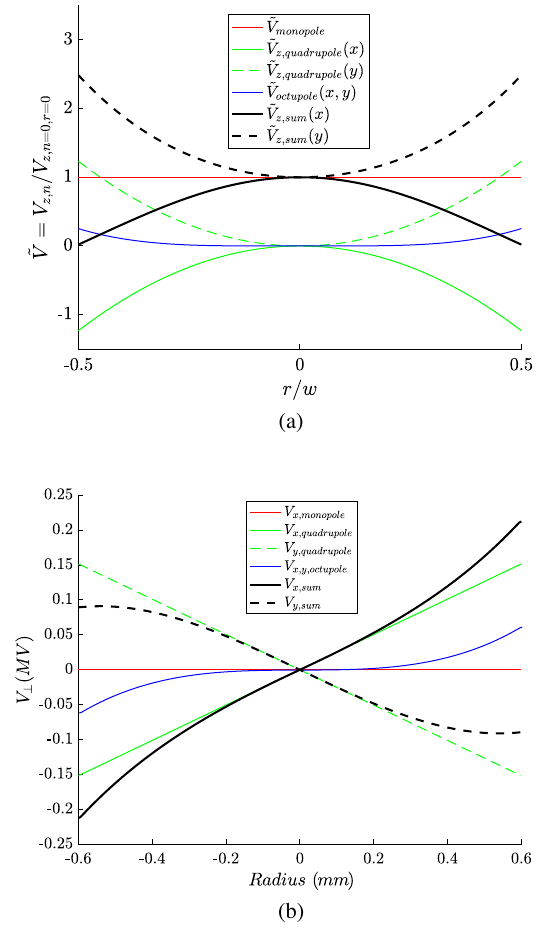
FIG. 3. Pure monopole, quadrupole and octupole components of the longitudinal potential and their sum in (a) for 0.465 THz and the geometry given in Fig. 1. (b) The corresponding trans- verse voltage for quadrupole and octupole components according to the Panofsky-Wenzel theorem for an amplitude of 100 MV = m. The radially constant longitudinal monopole field component yields a zero transverse monopolar